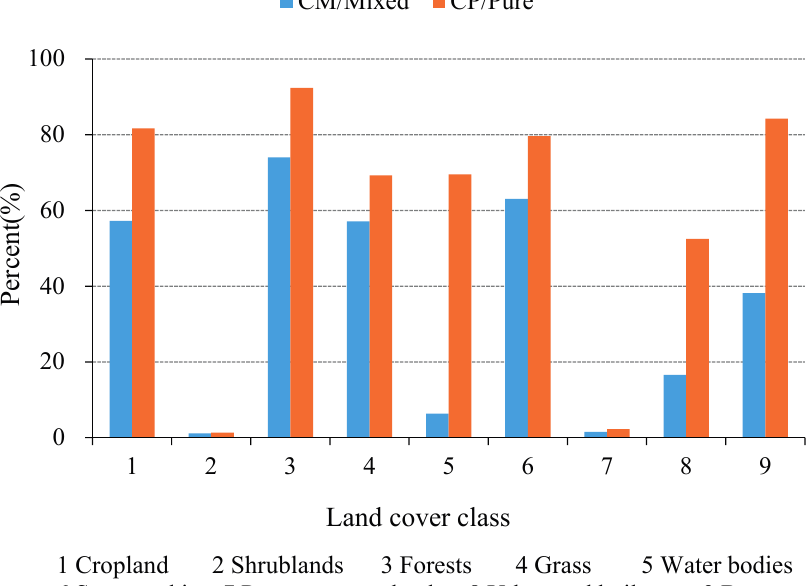
Figure 9. Proportions of correctly classified pixels in the pure and mixed pixels for the nine